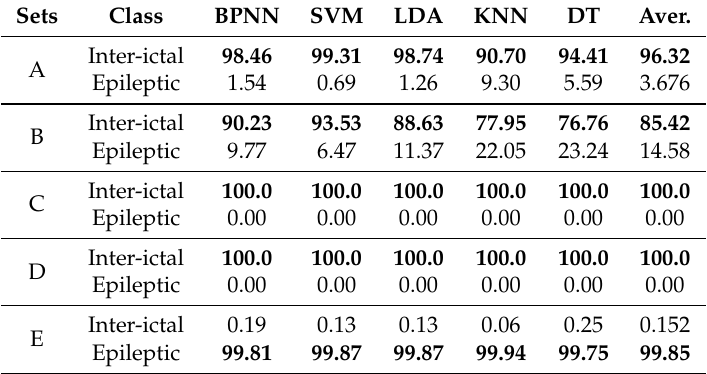
Table 4. Classification results of the five classifiers on all five data-sets of Case 2 (Back-Propagation Neural Network (BPNN), Support Vector Machine (SVM), Linear Discriminant Analysis